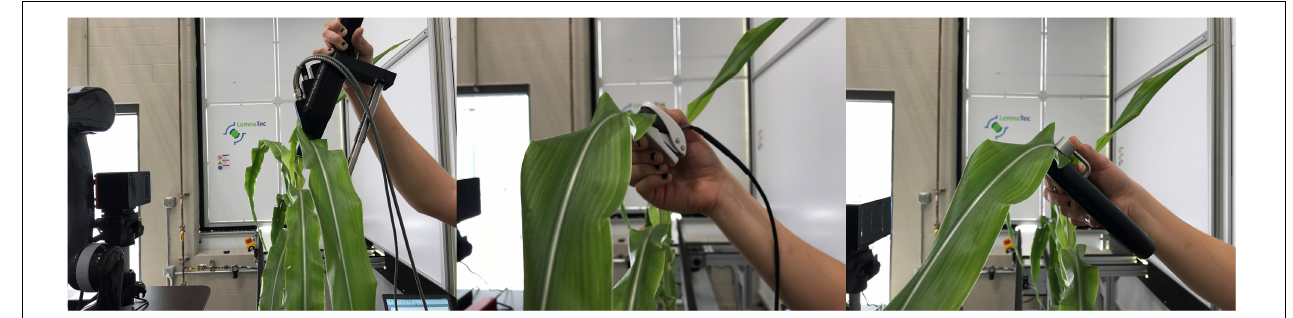
FIGURE 2 | Manual measurements of leaf reflectance (left) , leaf temperature (middle) , and chlorophyll content (right) (Atefi et al.,